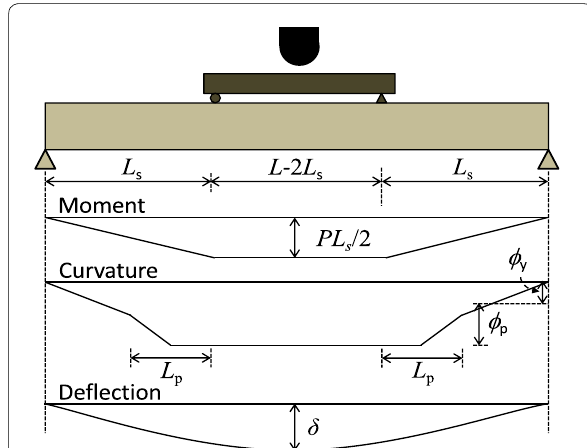
Fig. 8 Curvature distribution of test specimen.